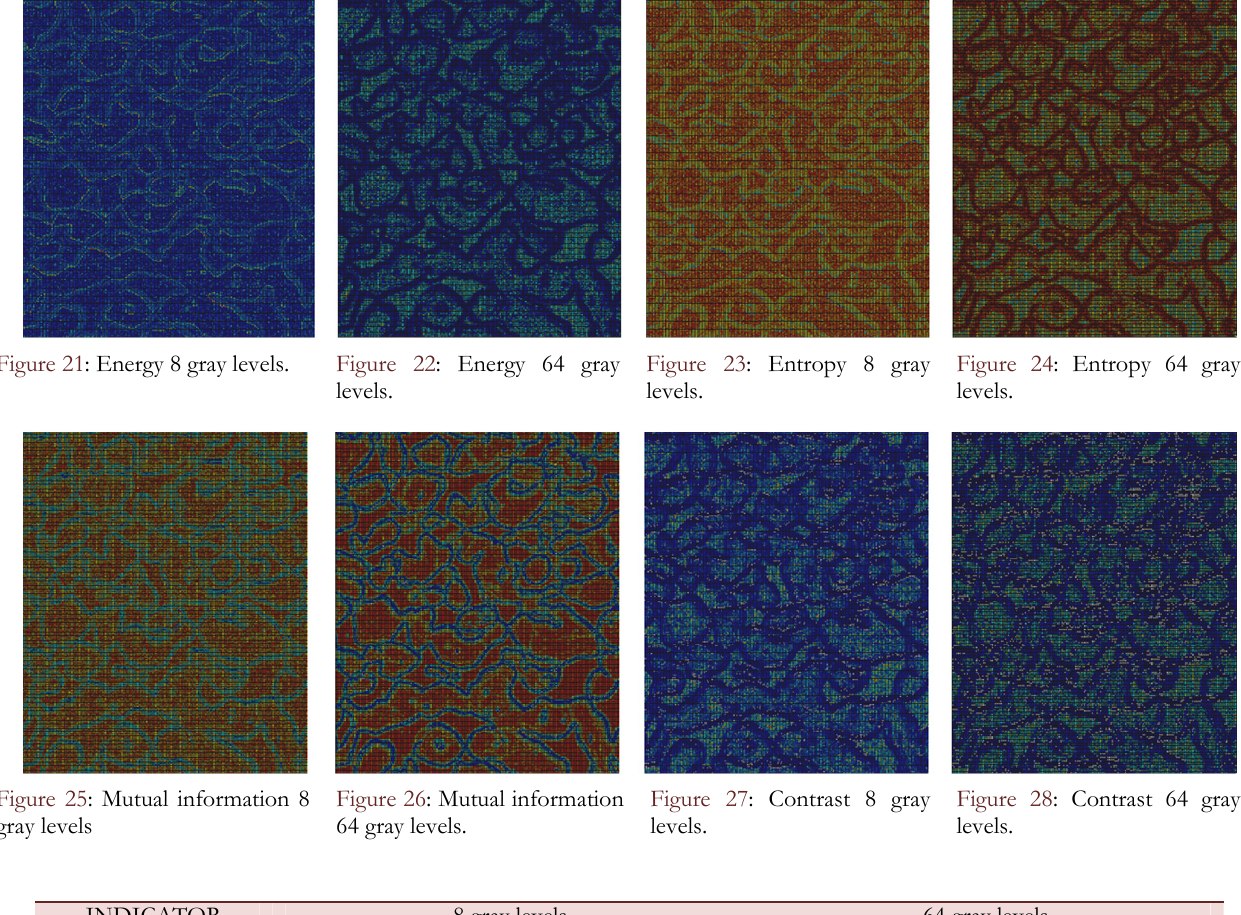
Figure 25: Mutual information 8 gray levels